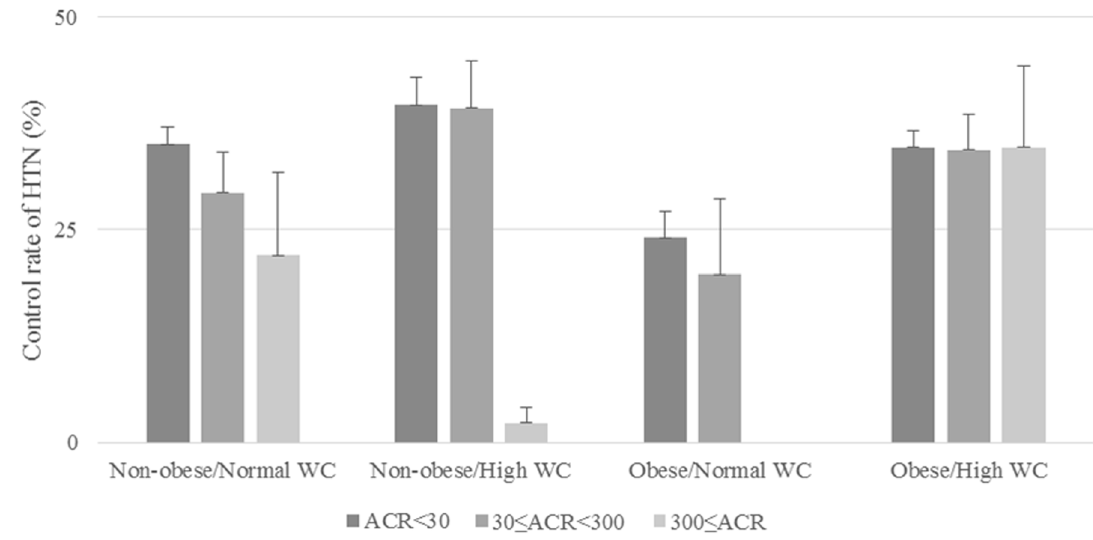
Figure 2. HTN control in subjects with and without obesity and abdominal obesity by tertile of ACR. P value for trend was , 0.001 for the non-obese/high WC group only. P values were , 0.05 between two groups; ACR , 30 vs. 30 # ACR , 300, and ACR , 30 vs. ACR $ 300 for the non- obese/normal WC group only. The p values and p values for trends were not statistically significant in the other three groups. HTN, hypertension; ACR, albumin–creatinine ratio; WC, waist circumference.